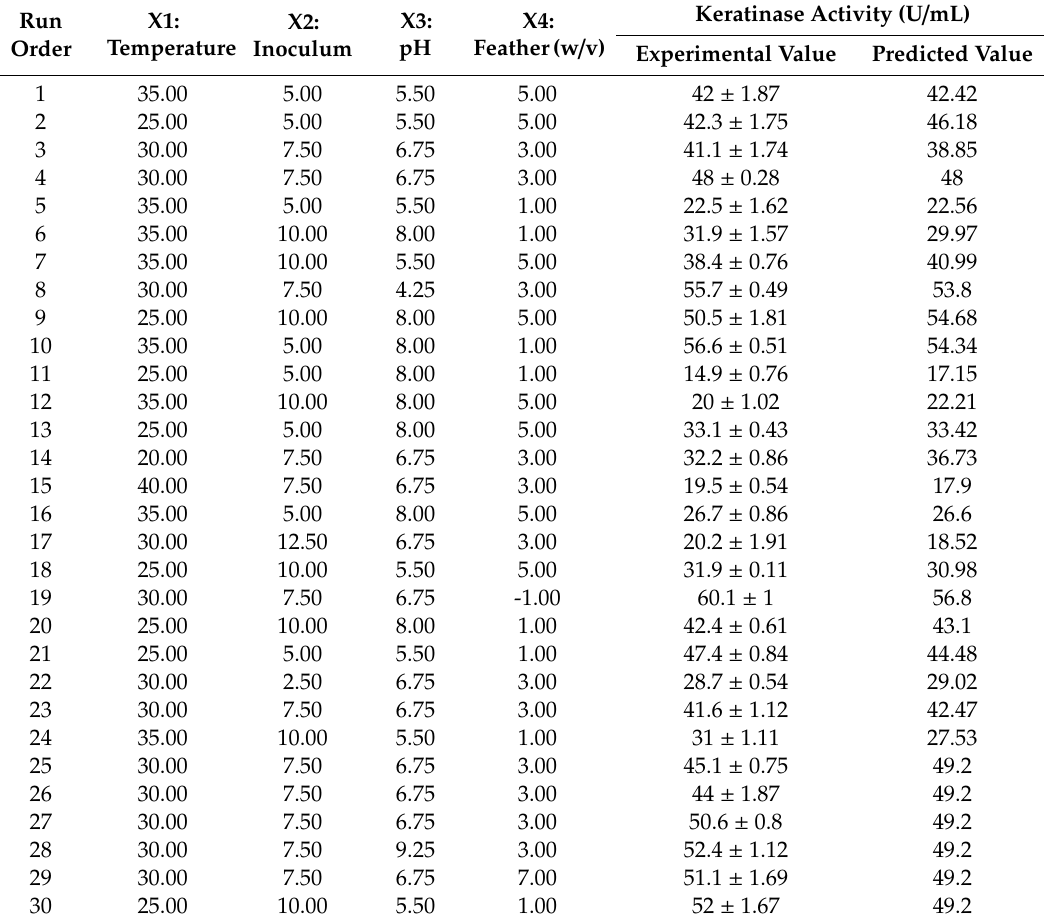
Table 3. Optimization of keratinase activity by strain AAG-1 using central composite design (CCD) with six center points showing observed and predicted values ( ± standard deviation, n =